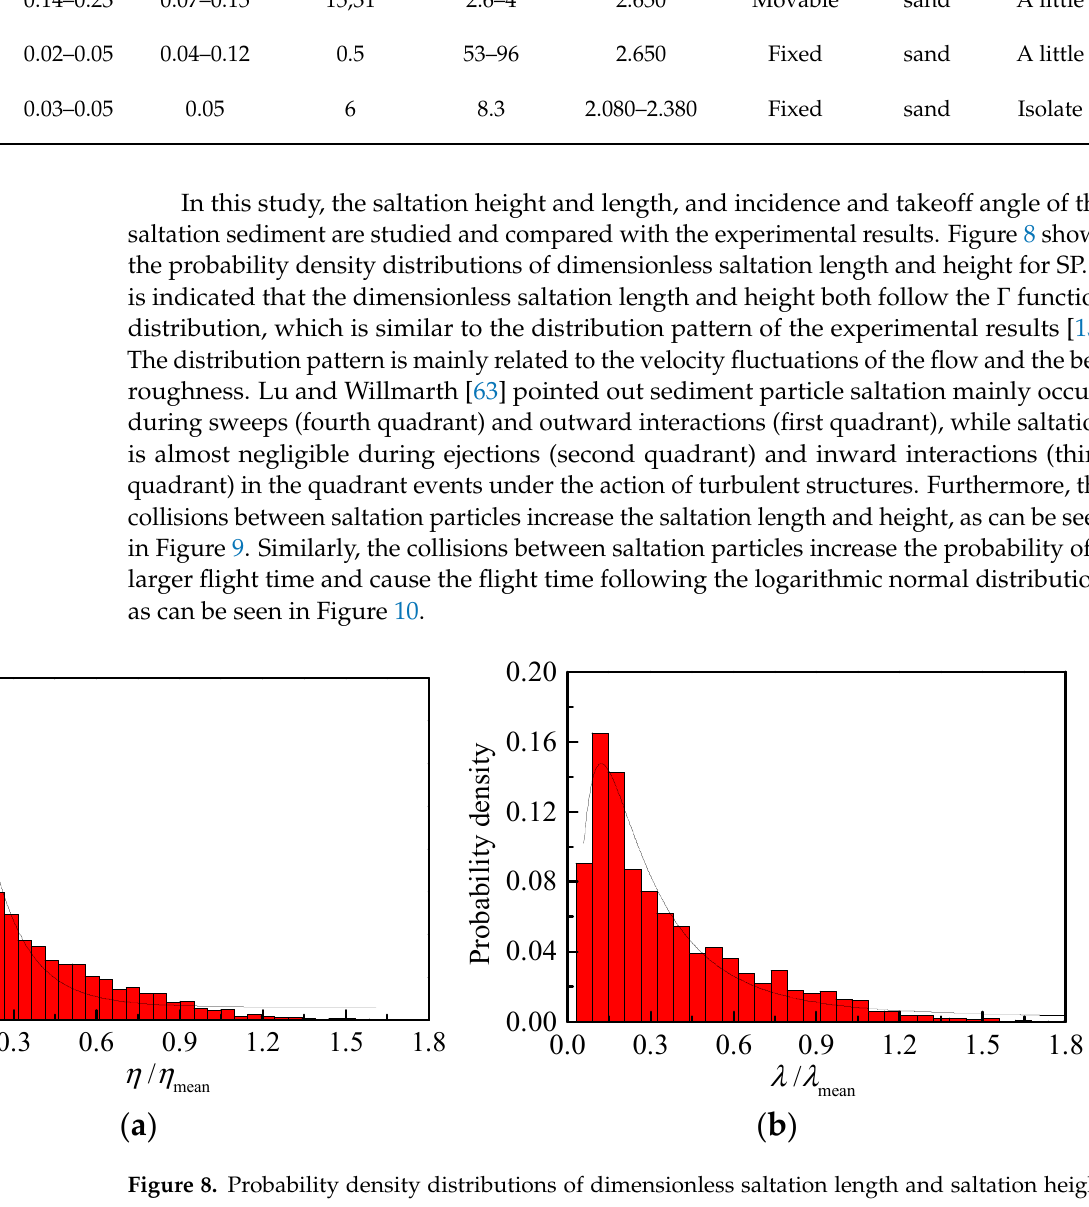
Figure 8. Probability density distributions of dimensionless saltation length and saltation height. ( a ) Saltation length. ( b ) Saltation height.